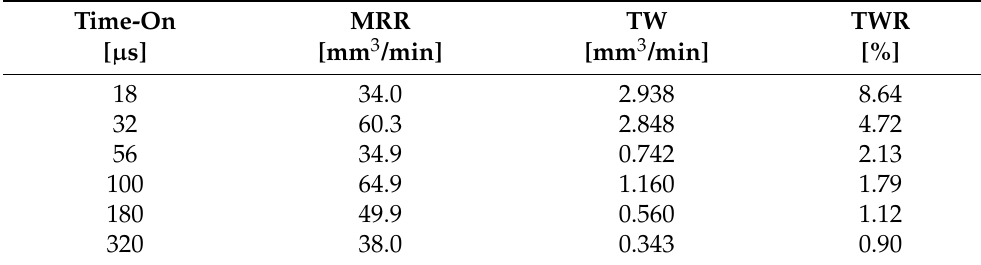
Table 3. Numerical results.